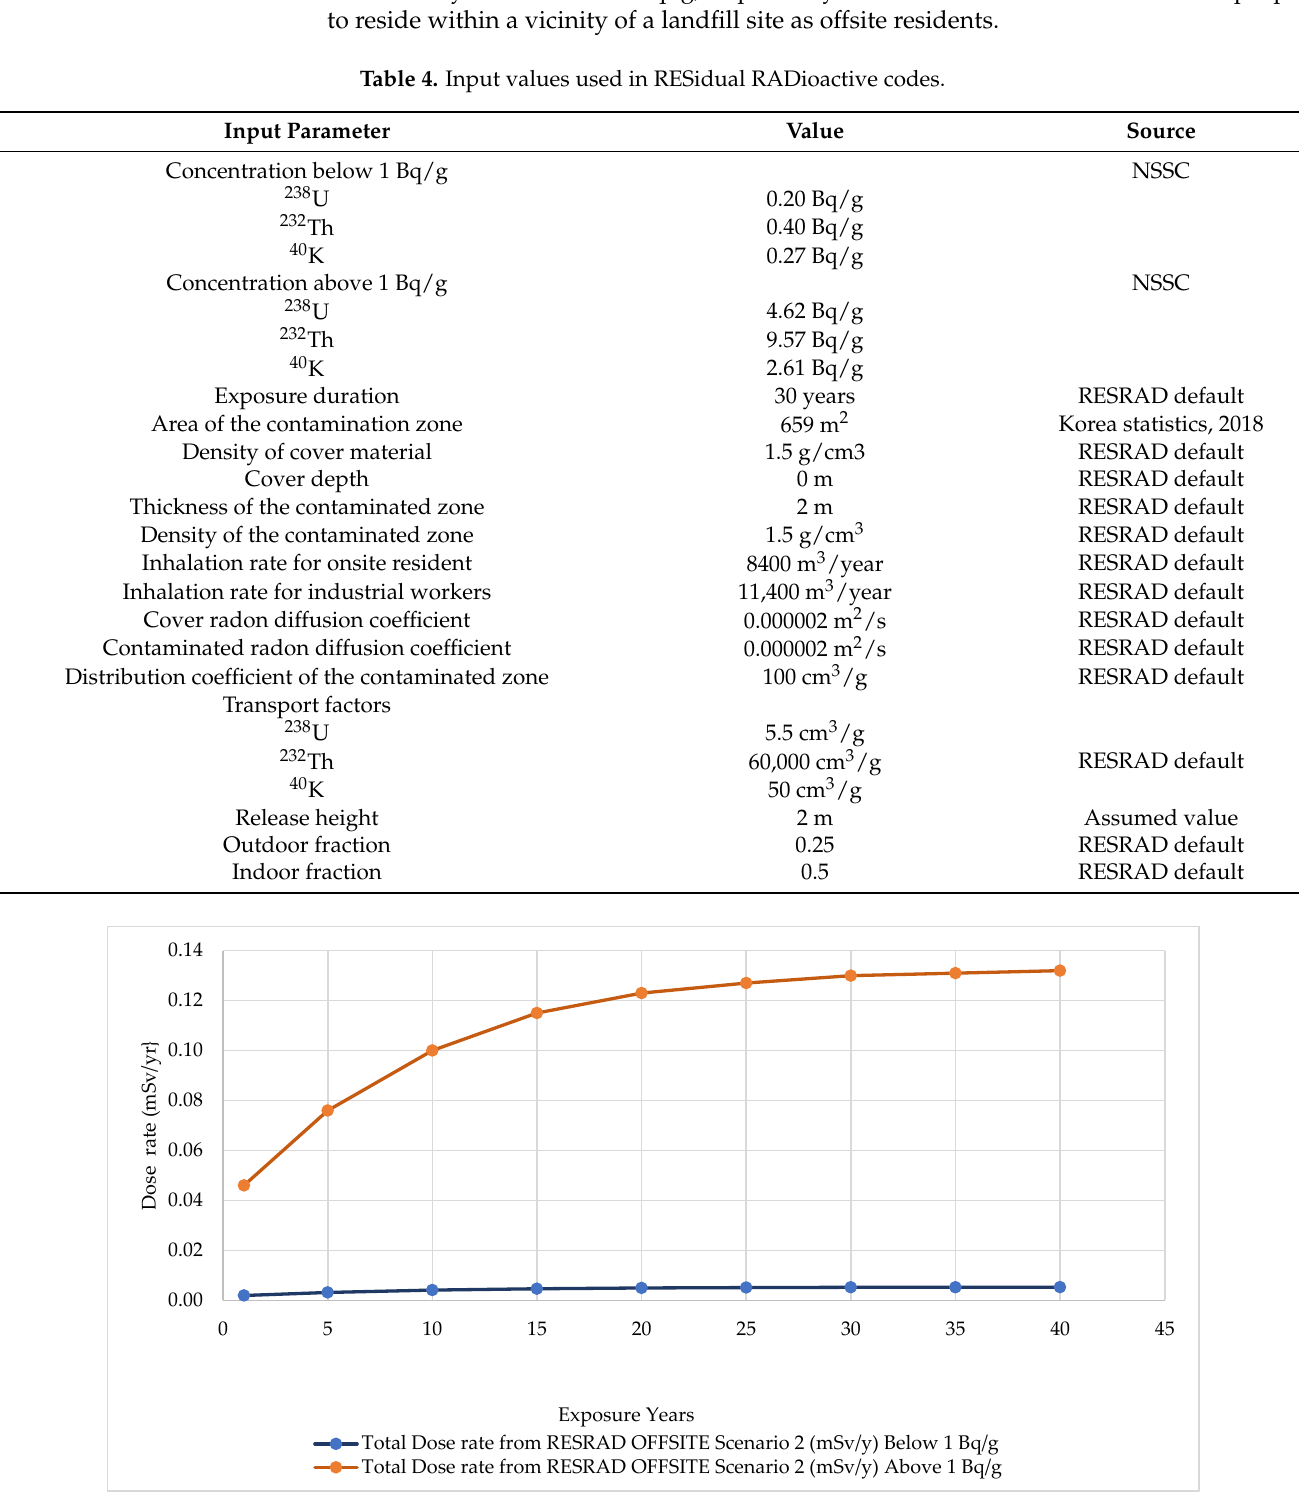
Table 5. Input values used in HOTSPOT. Parameters